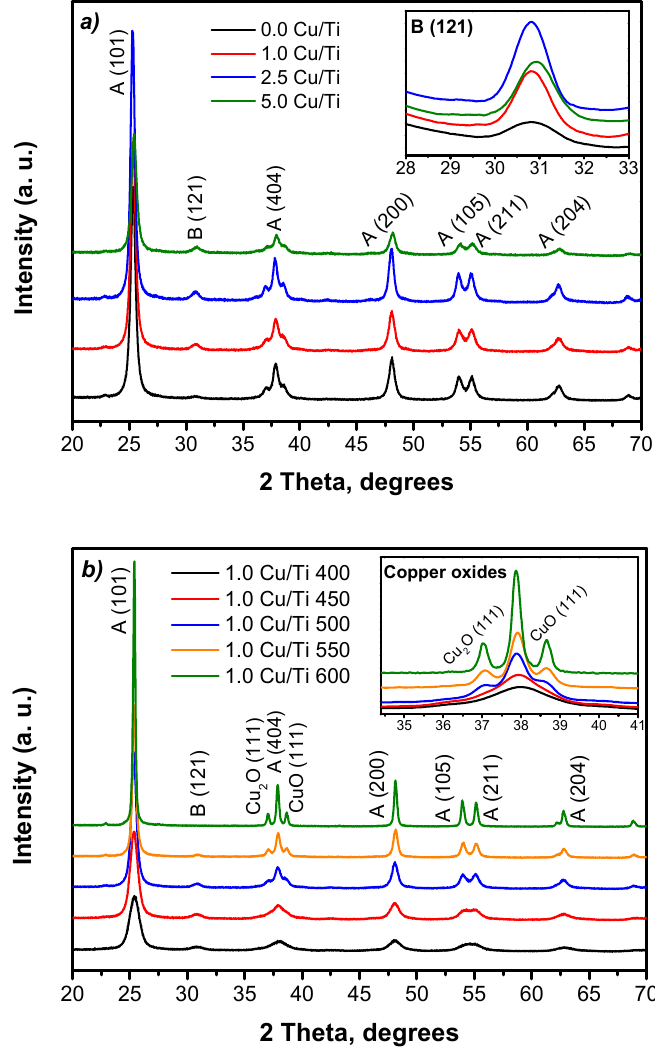
Figure 1. X-ray diffractograms of ( a ) X Cu/Ti 500, and ( b ) 1.0 Cu/Ti calcined at different temperatures. The insets correspond to the brookite (121) crystallographic plane and copper oxides, respectively. Table 1. Physicochemical properties of the Cu/Ti